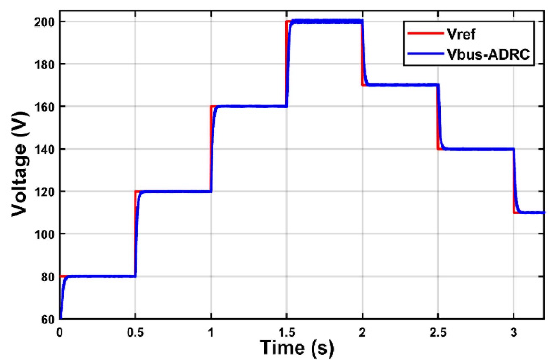
Figure 7. Output voltage response for different voltage reference.